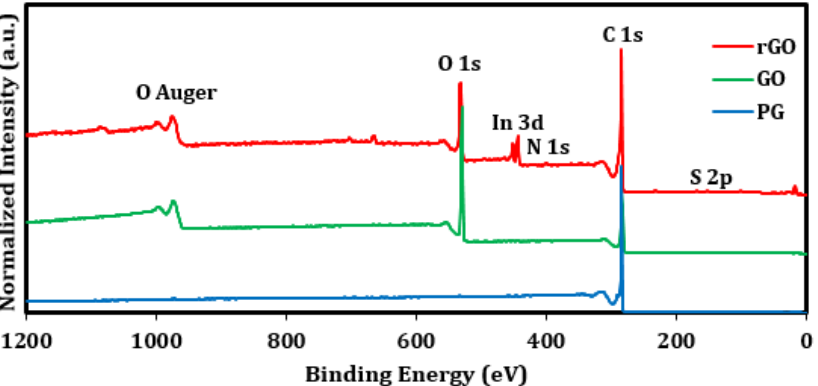
Table 2. XPS compositional analysis and quantitative peak fittings of C 1s and O 1s scans.